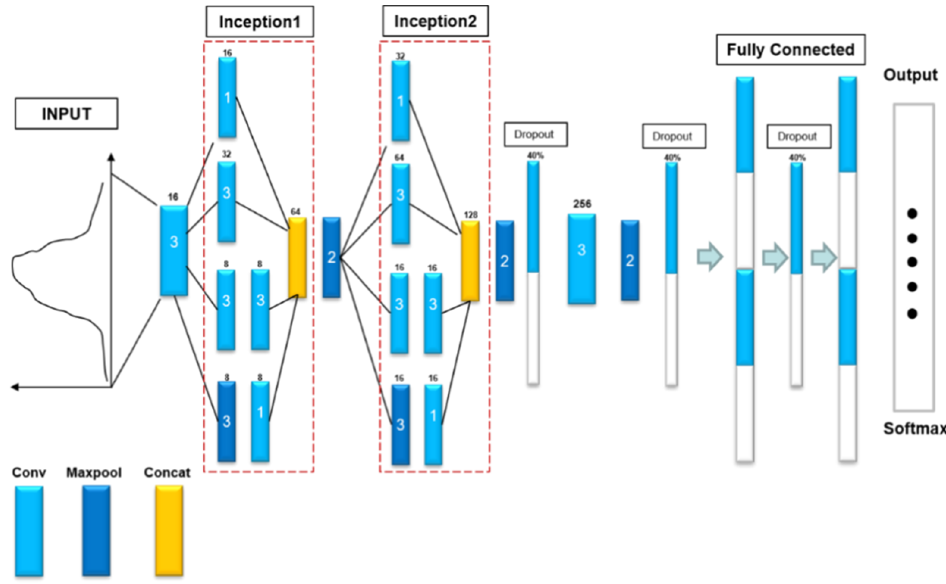
Figure 3. Schematic diagram of the one-dimensional convolutional neural network (Conv1D) used in this study. The black dots in the output layer indicate classification probabilities of each crop.